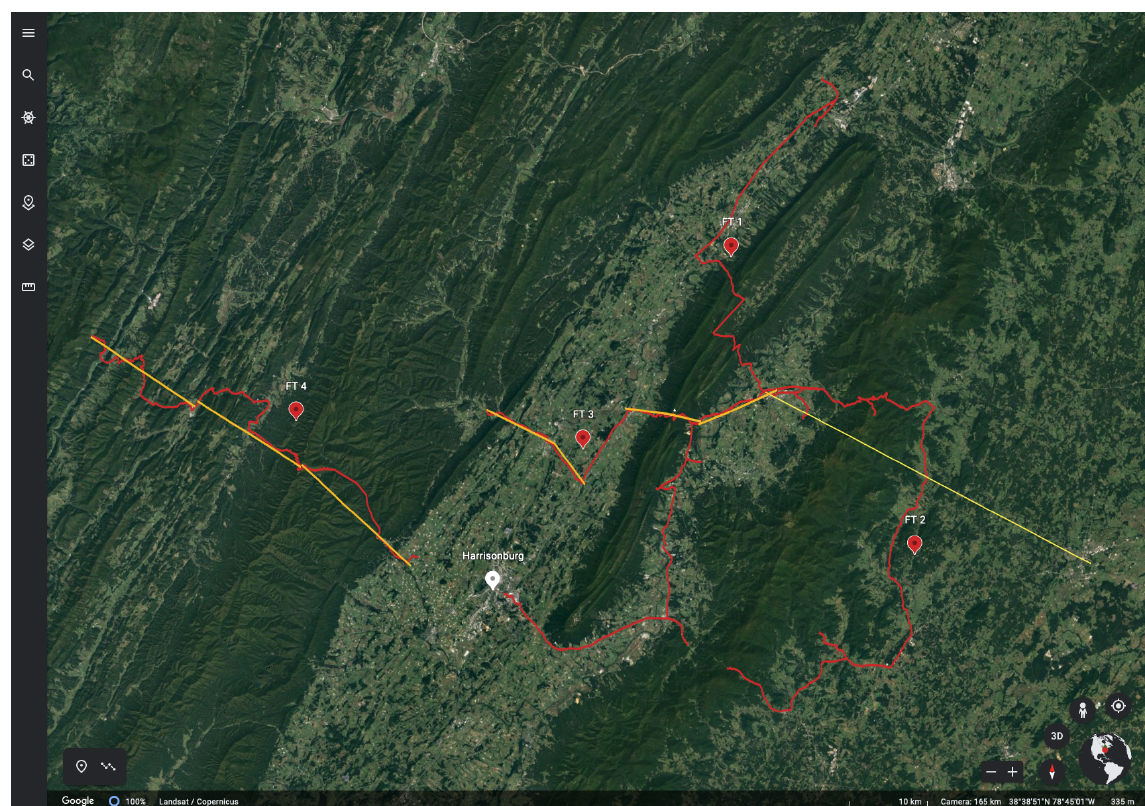
Figure 1. Screen image showing locations of web-based © Google Earth virtual field trips in eastern West Virginia and western Virginia from the Mid Atlantic Appalachian Orogen Traverse project; red lines indicate the paths of each field trip (labeled FT1, FT2, FT3, FT4), and the yellow lines show the locations for each cross section that students draft for the